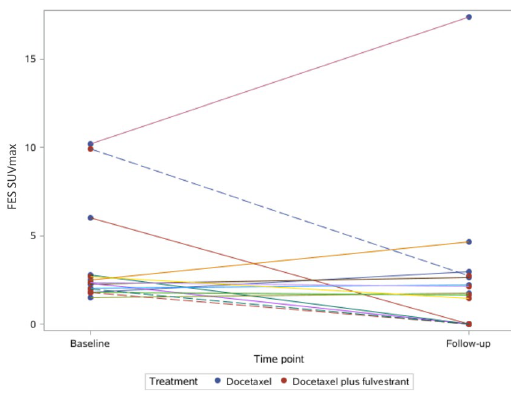
Figure 4. The spaghetti plot of 18 F-FES changes.